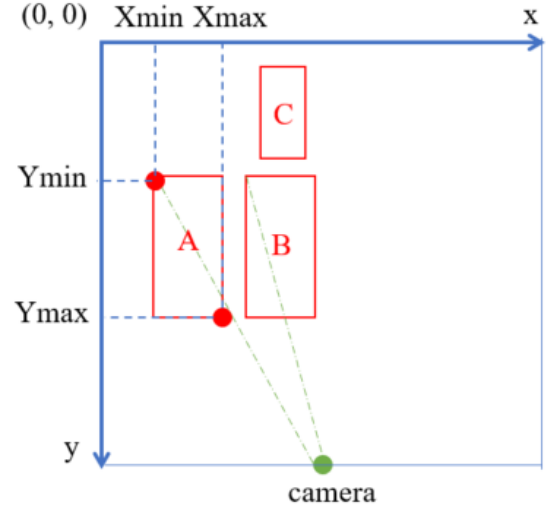
Figure 23. One sample frame with three different bounding boxes.